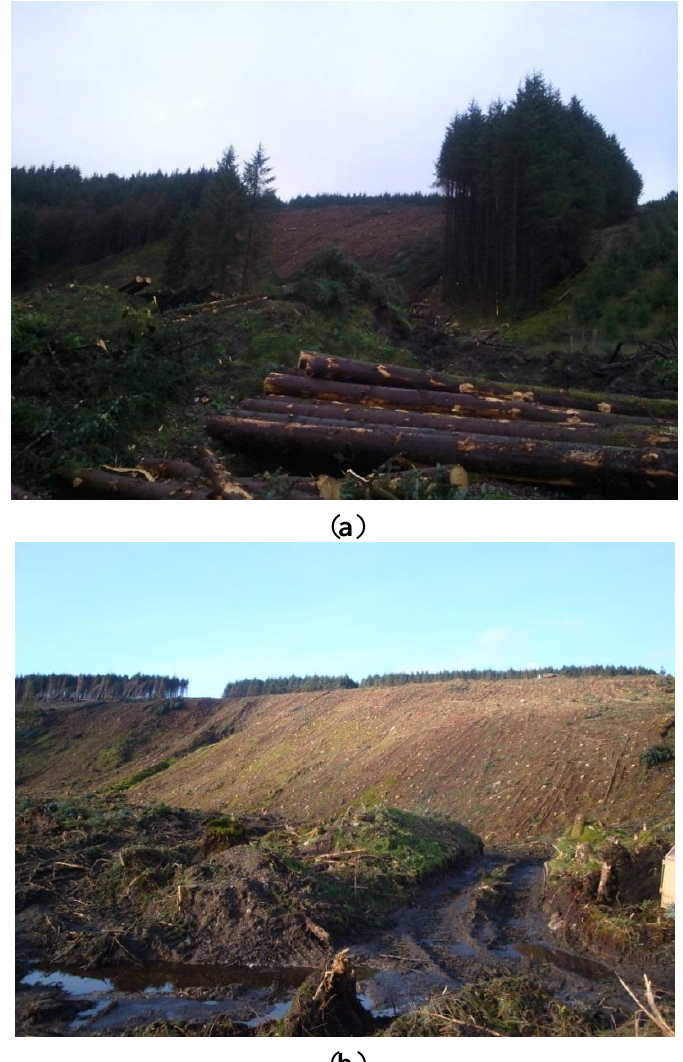
Figure 4. ( a ) Panoramic view of cable log SC I & II; ( b ) panoramic view of final clearfelled SC I &